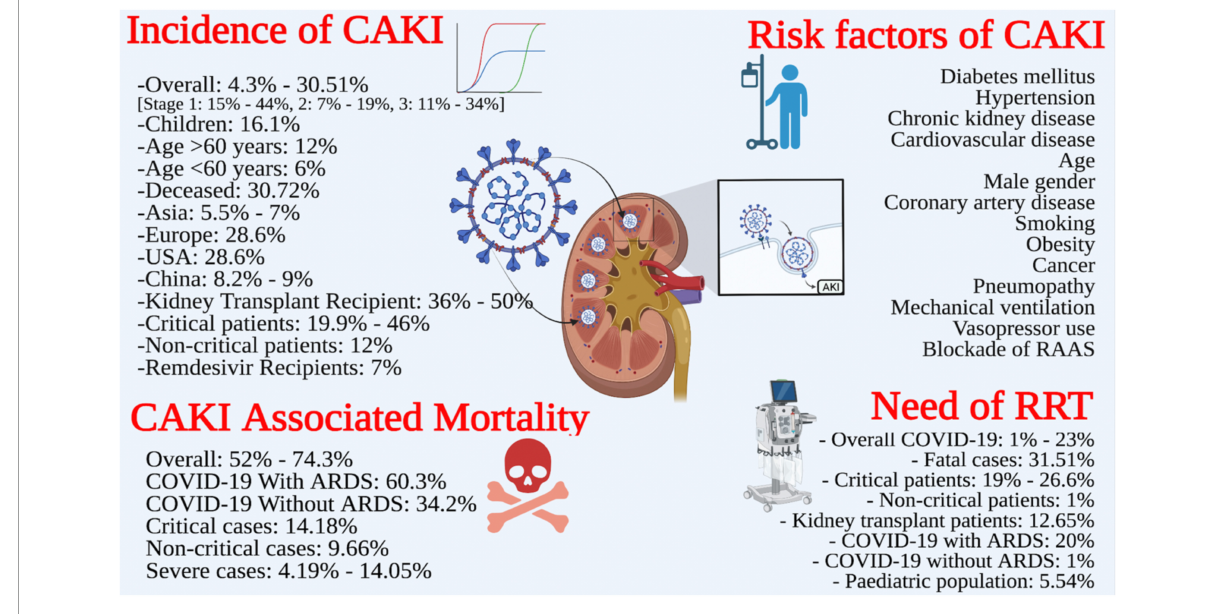
FIGURE4 Review summary: incidence, risk factors, need for renal replacement therapy (RRT), outcomes of